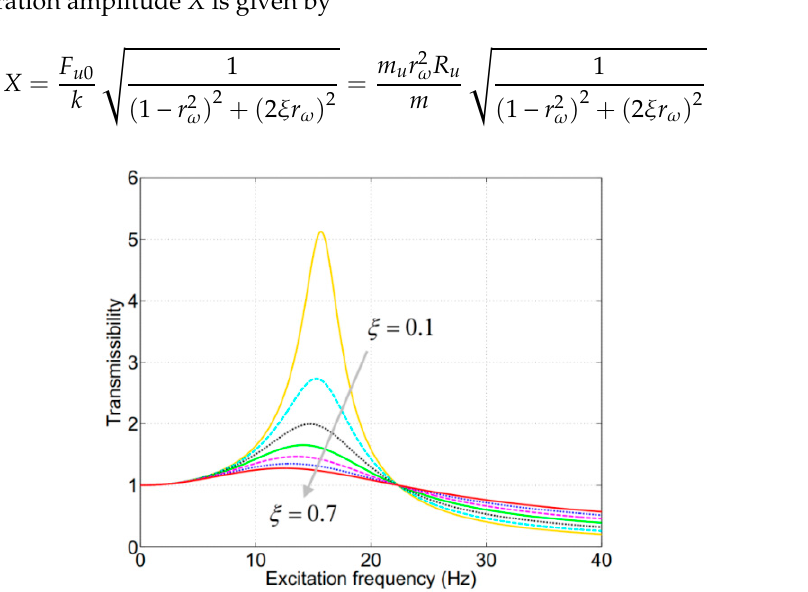
Figure 8. Relation between the force transmissibility and the excitation frequency under a damping ratio of 0.1–0.7 with an increment of 0.1.